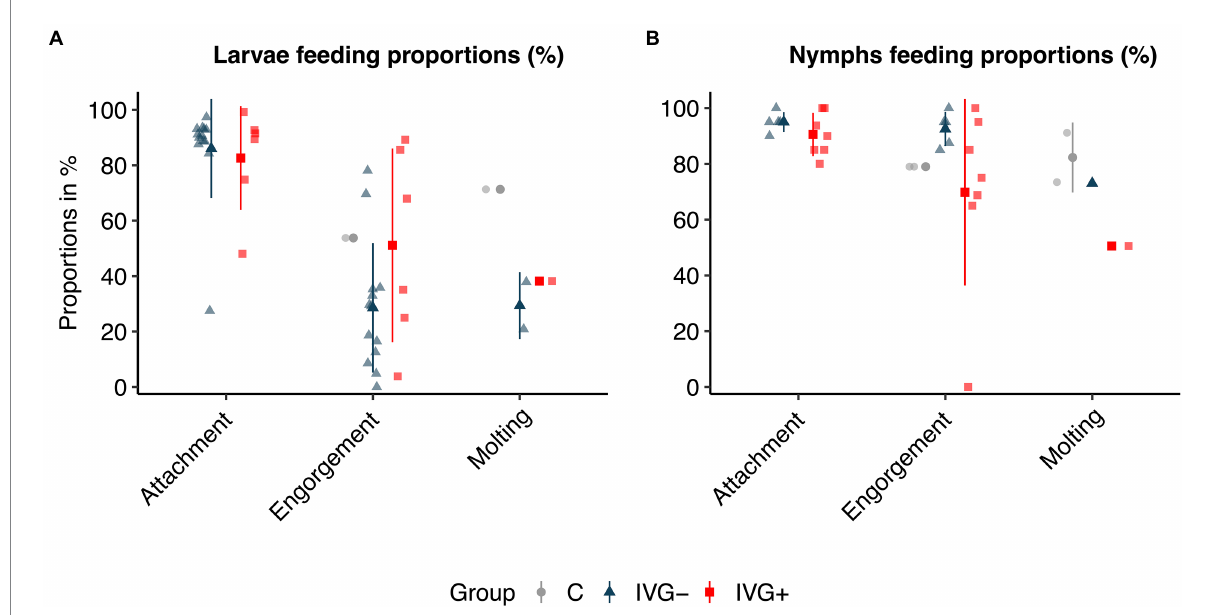
FIGURE 1 Attachment, engorgement, and molting proportions of Ixodes ricinus larvae (A) and nymphs (B) . Proportions are presented in % per feeding unit or per animal experiment. Bars present means ± standard deviation. IVG + , in vitro feeding with gentamicin; IVG − , in vitro feeding without gentamicin; C, control feeding in vivo on